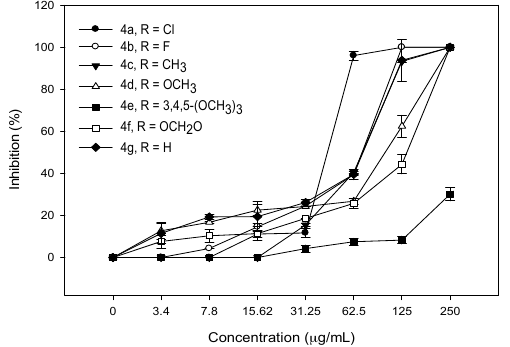
Figure 2. Dose-response curves of compounds 4a – g against C. neoformans ATCC 32264.